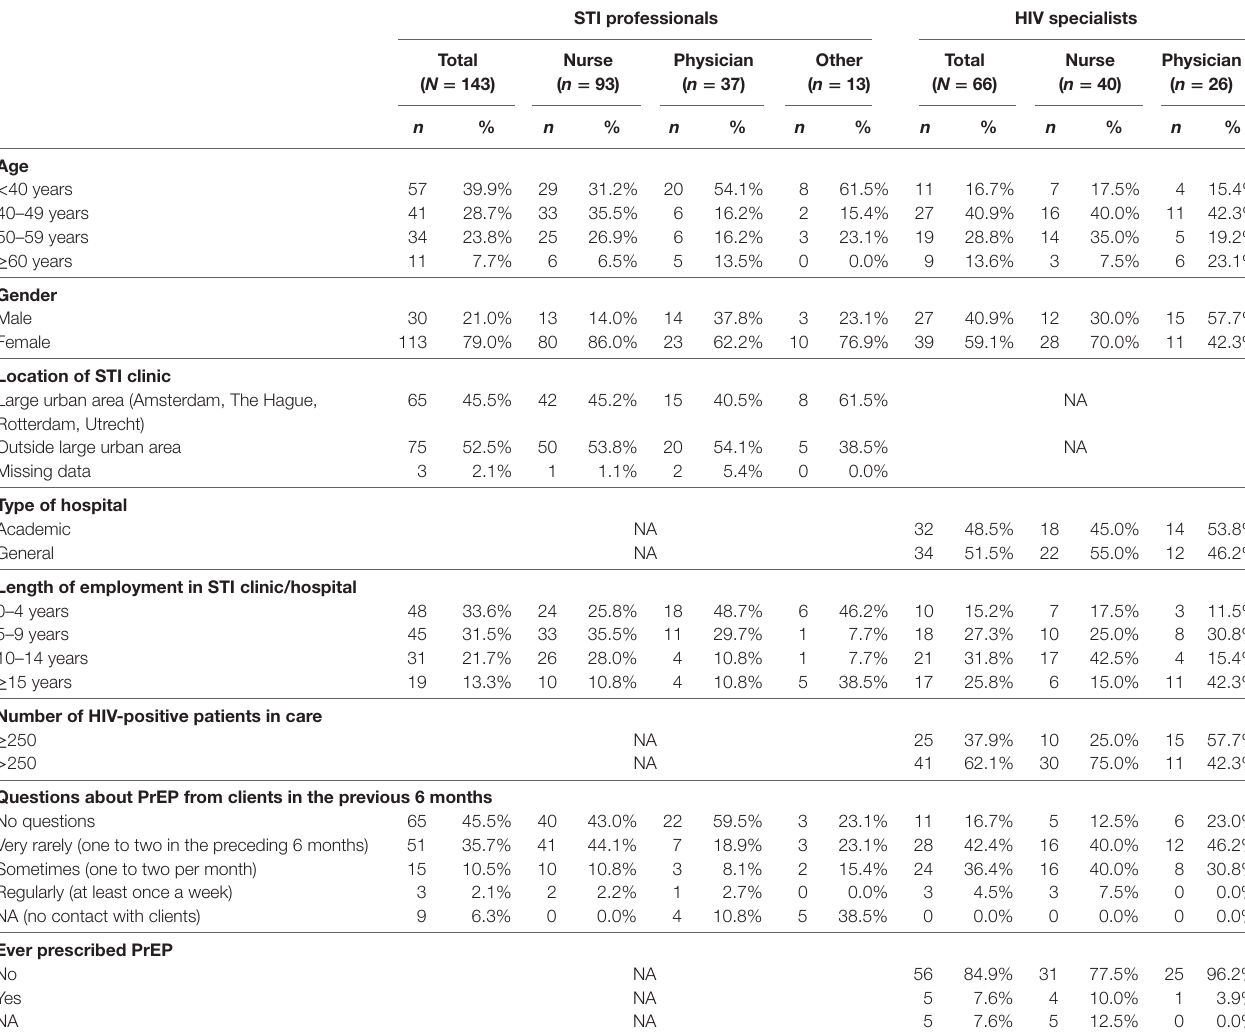
TaBle 1 | Demographic characteristics and PrEP experience of 209 health-care professionals the Netherlands